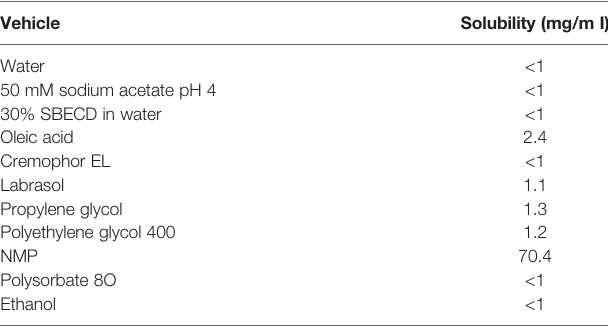
TABLE 3 | Stability analysis. TABLE 2 | Vehicle/excipient